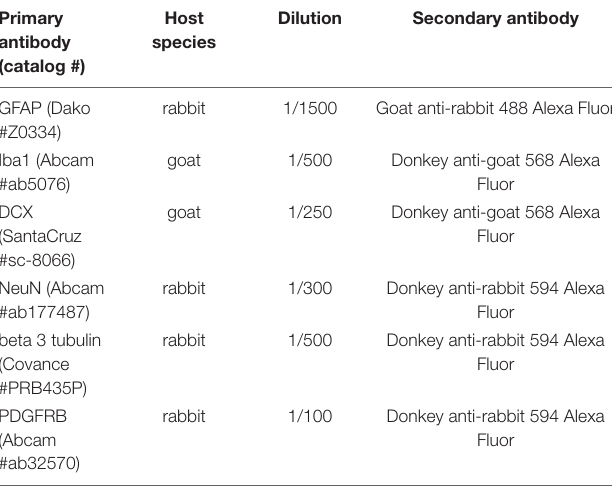
TABLE 2 | List of primary and secondary antibodies used in the